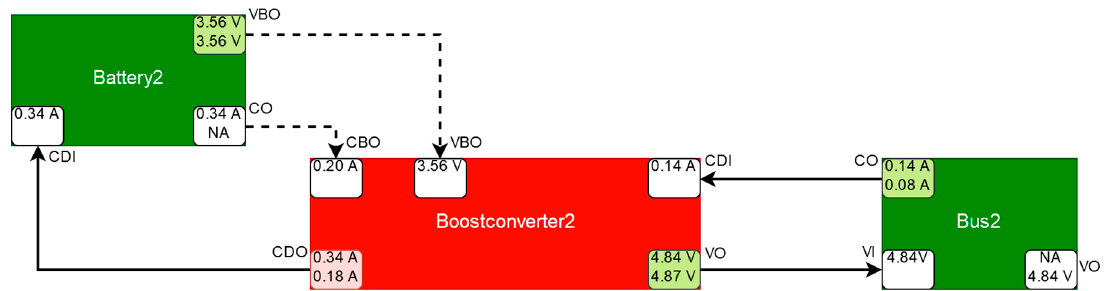
Figure 20. Simplified schematic depiction of the suspected component Boostconverter2 in red together with its adjacent components (not suspected, therefore in green), taken over from the satellite model from Figure 19 with relevant ports (boxes within the components with their abbreviated names above the boxes, e.g., VBO) and relevant port values (values within the port boxes if available, top value: measured, bottom value: simulated). Forward connections are depicted by solid arrows, backward connections by dotted lines. Comparisons between measured and simulated values are performed at the output ports (denoted with an outgoing arrow; if an output value is not available, it is denoted with “NA”; the port box color denotes red for detected discrepancies, green for correct and white for unknown). Input ports are white, because they do not compute discrepancies, and use measured values if available, otherwise simulated values.